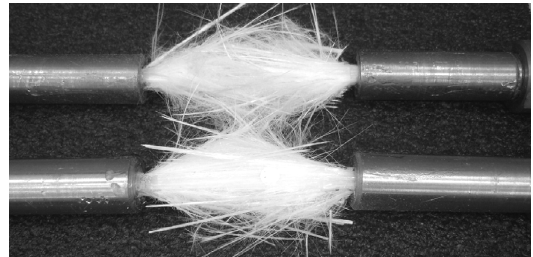
Figure 6: Failed unidirectional fiberglass (Direct "E" roving 0.7 - orthophthalic polyester resin 0.3) specimens after uniaxial tensile tests.